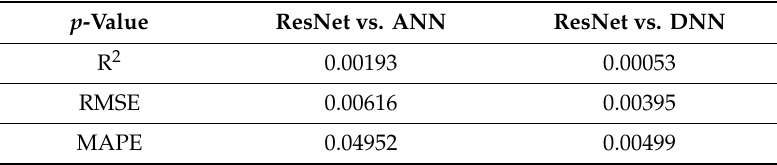
Table 6. Paired t -test for statistical significance between ResNet and ANN-based models (architecture 6 and 1) and between ResNet and DNN-based models (architecture 6 and architecture